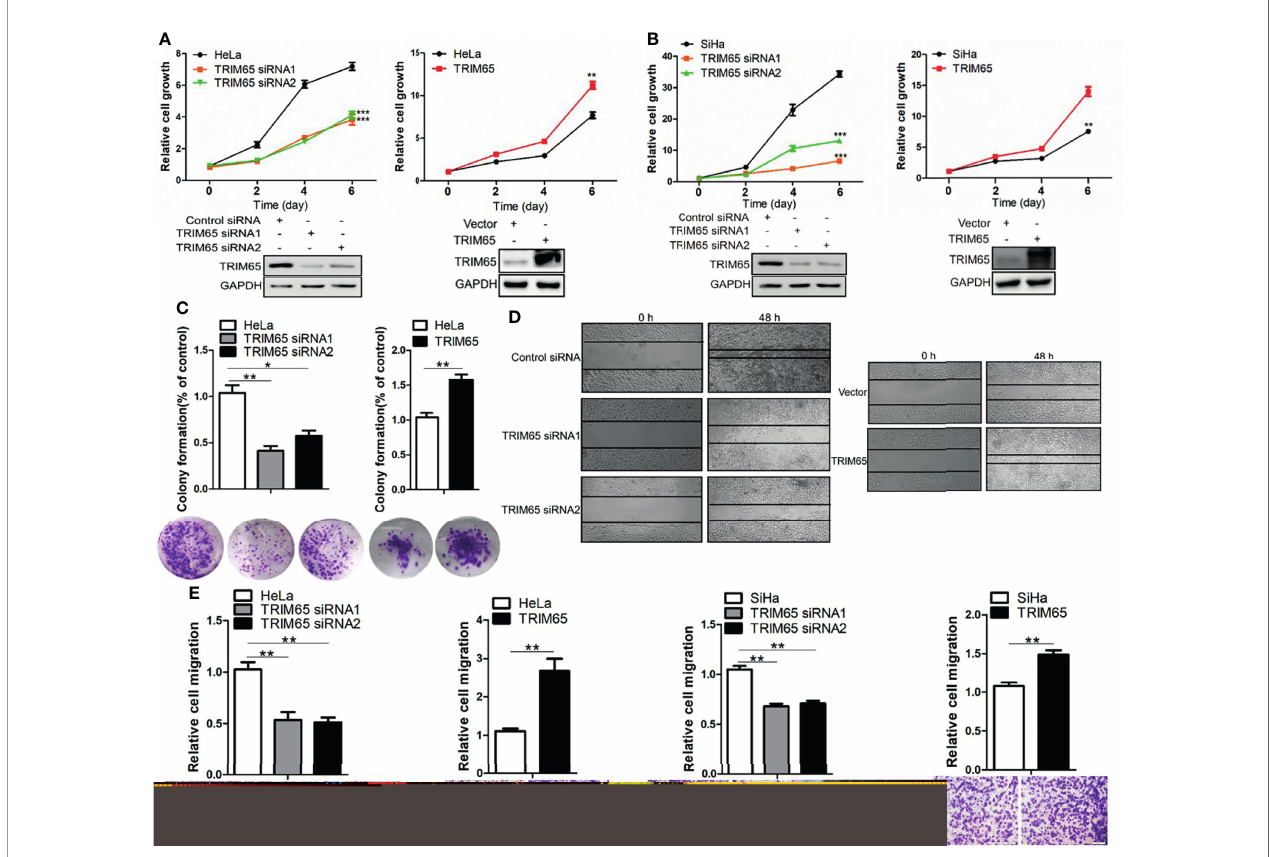
FIGURE 2 | TRIM65 facilitates the proliferation and migration of cervical cancer cells. HeLa (A) and SiHa (B) cells were transfected with siRNAs or TRIM65 overexpression vector. After 24 h, the cells were seeded in 96-well plates at 2000 cells per well. At the indicated times, related cell growth was measured by CCK-8 (cell counting kit-8) in HeLa and SiHa cells with TRIM65 depletion (left) or overexpression (right). The statistical data was shown (Top panel). Immunoblot experiment was used to check the knockdown and overexpression ef fi ciency of TRIM65 in both cell lines (Bottom panel). (C) HeLa cells were transfected with TRIM65 overexpression vector or siRNAs to determine cell proliferation by colony formation assay. A quantitative analysis of the colony was shown in the bar diagram. (D) Wound healing assay was used to con fi rm the effects of TRIM65 knockdown or overexpression on cell migration. (E) HeLa and SiHa cells were transfected with TRIM65 overexpression vector or siRNAs to show that TRIM65 was capable of enhancing cell migration by transwell assays. Bar diagram represents relative capable of cell migration. Scale bar = 200 m m. Data are presented as mean ± SD. The experiments were repeated three times independently and the data of one representative experiment was shown. *p < 0.05; **p < 0.01, ***p <